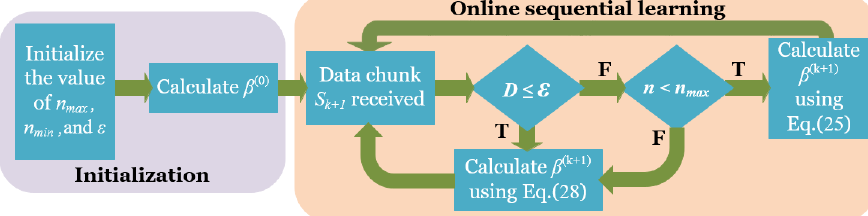
Figure 1. The diagram of the AKOS-ELM